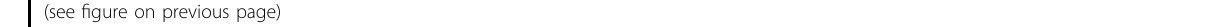
Fig. 2 Overdose concentration of LiCl-induced epileptiform activity is comparable to GABA A receptor antagonist-induced epileptiform activity in human cortical networks. A Schematic representation of the applied protocol to evaluate the chemically induced epileptiform activities with LiCl and picrotoxin (PTX) in the hiPSC-derived 3D-neural aggregate cultures with synchronous network activity (day 20 – 50 after seeding). B Representative MEA-recordings (three individual channels are shown) showing the properties of network activity at baseline and after the application of ( B , i ) 10 mM LiCl or ( B , ii ) 50 µM PTX. C Representative MEA-recordings ( fi ve-minute, one channel) showing the epileptiform activity induced by C, i 10 mM LiCl or C , ii 50 µM PTX. The blue lines are marking the different stages of epileptiform activities: the population super-bursts (PSB) are proceeded by prominent spiking and are followed by a period of complete inactivity or silence. C Spike raster plots and population fi ring rate diagrams showing the epileptiform events induced by C , iii LiCl and C , iv PTX. D , i Diagrams illustrating the neuronal network parameters in response to 10 mM LiCl and PTX. D , ii Diagrams showing no change in network properties in the corresponding control experiments with equimolar NaCl and DMSO. n = 6, N = 2. The data is presented as mean ± standard deviation. A two-tailed, paired or unpaired t test was applied to calculate the shown p